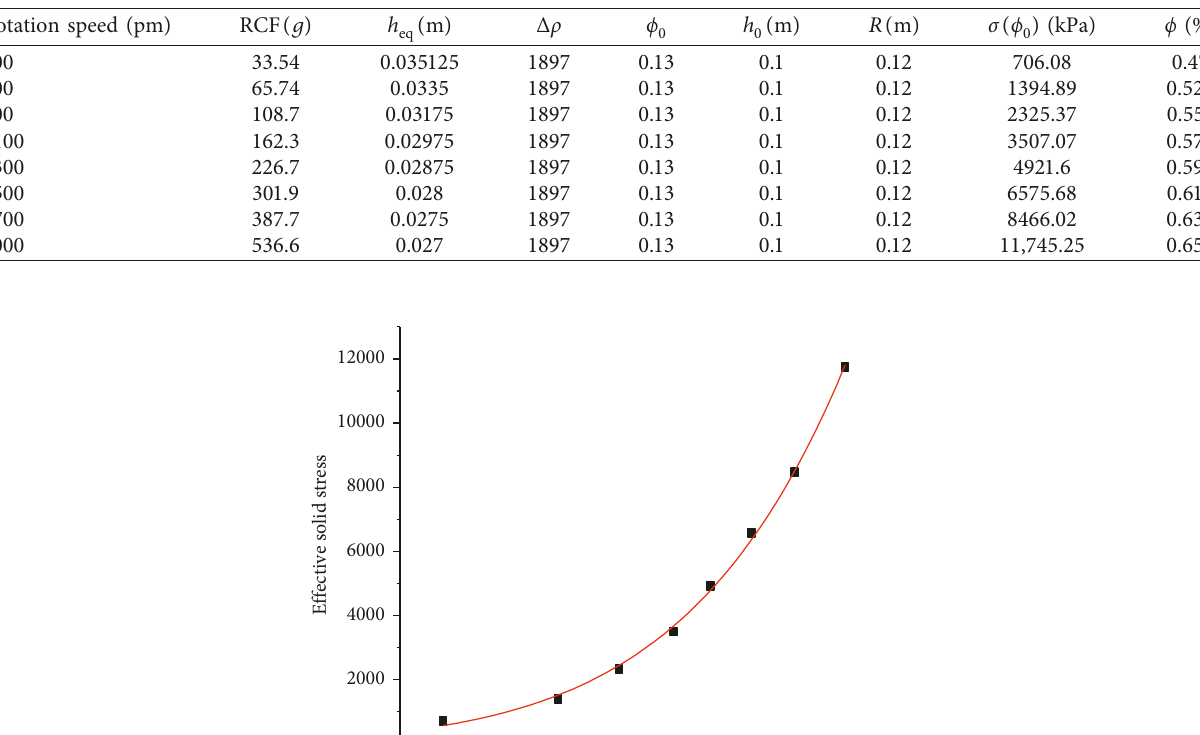
Table 2: Results of centrifuge tests.